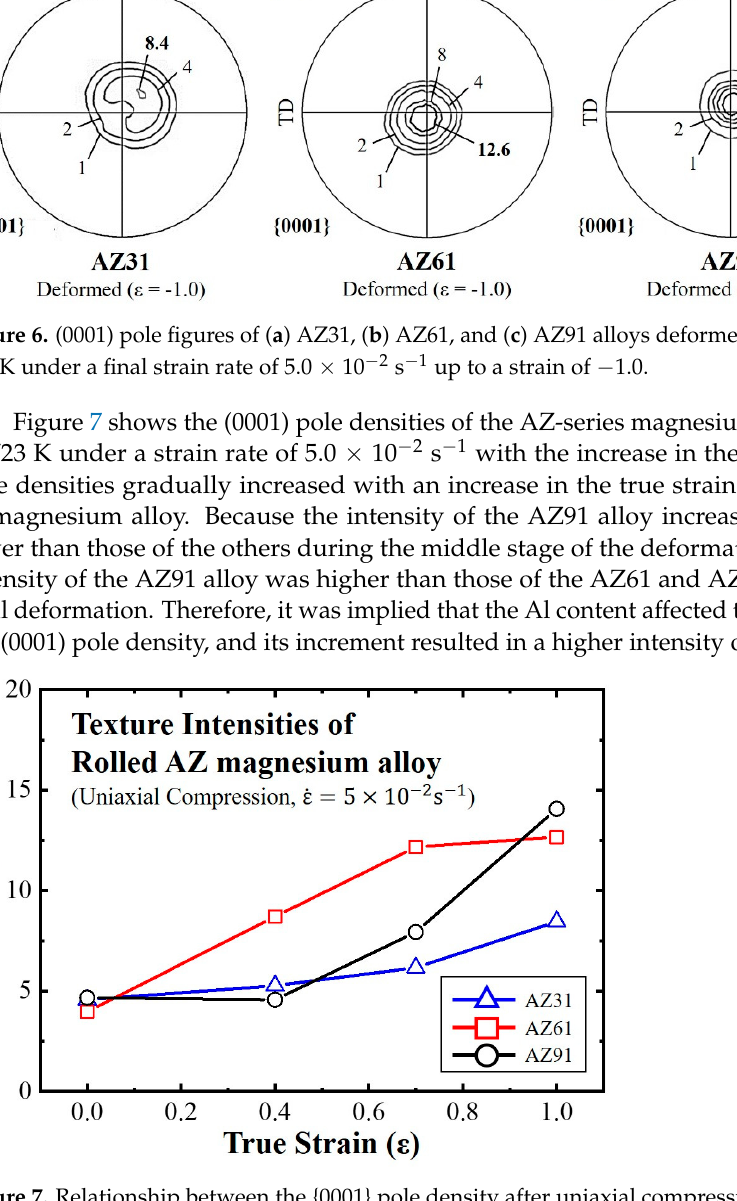
Figure 7. Relationship between the {0001} pole density after uniaxial compression and true strain.